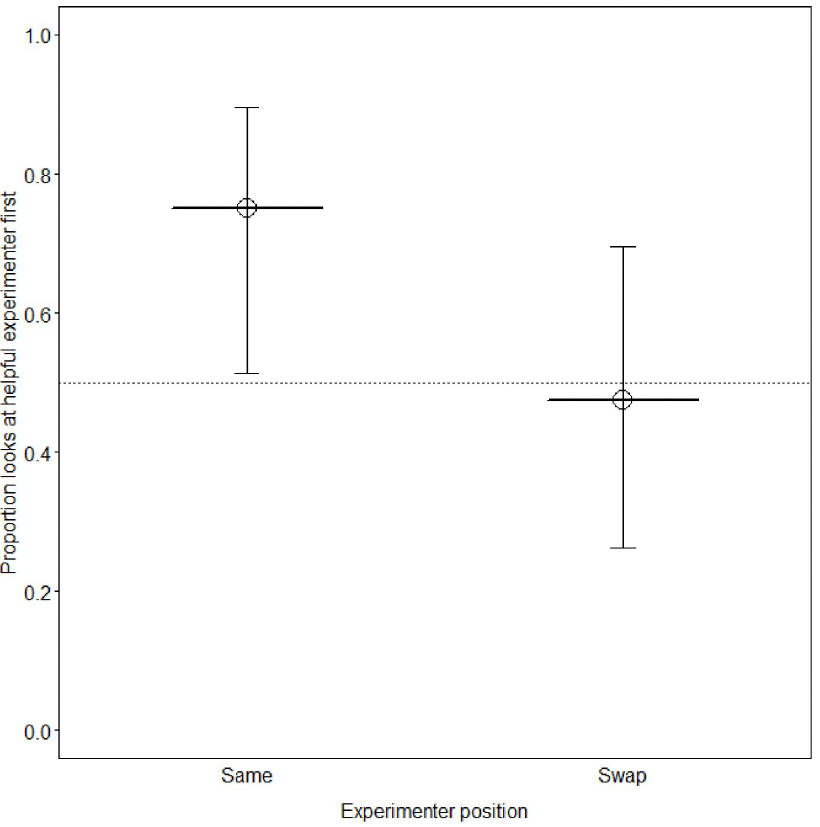
Fig 4. Proportion of dogs that looked at the helpful experimenter first in the impossible task. The solid horizontal lines depict the fitted model and the dotted horizontal line depicts chance expectation.